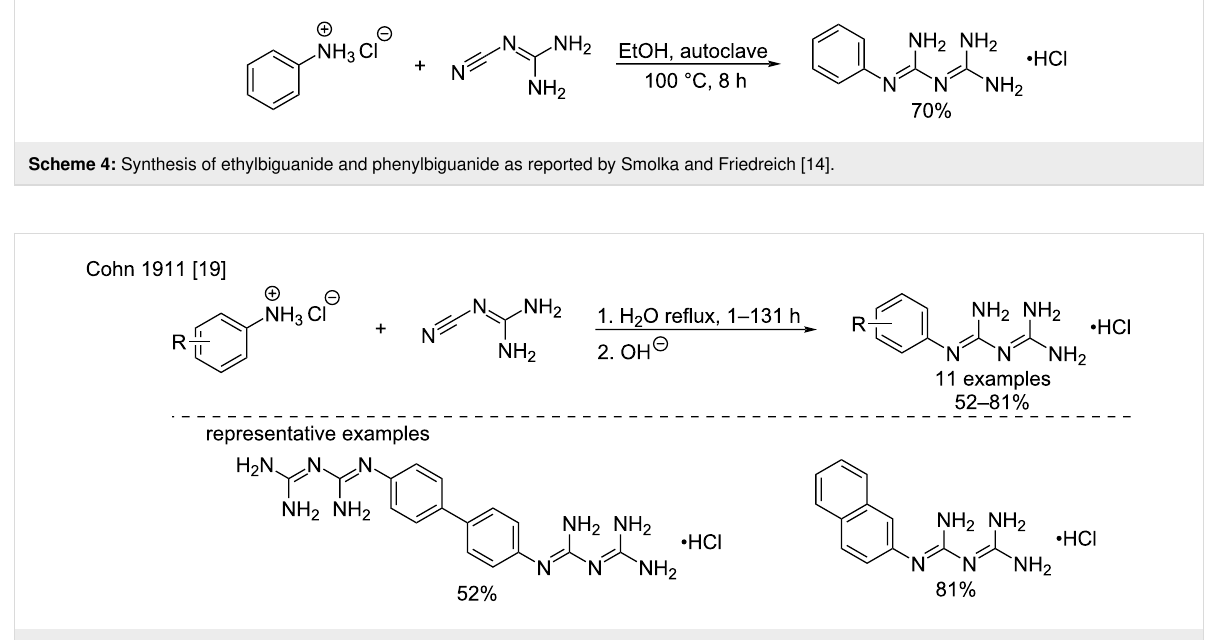
Scheme 5: Synthesis of arylbiguanides through the reaction of cyanoguanidine with anilines in water